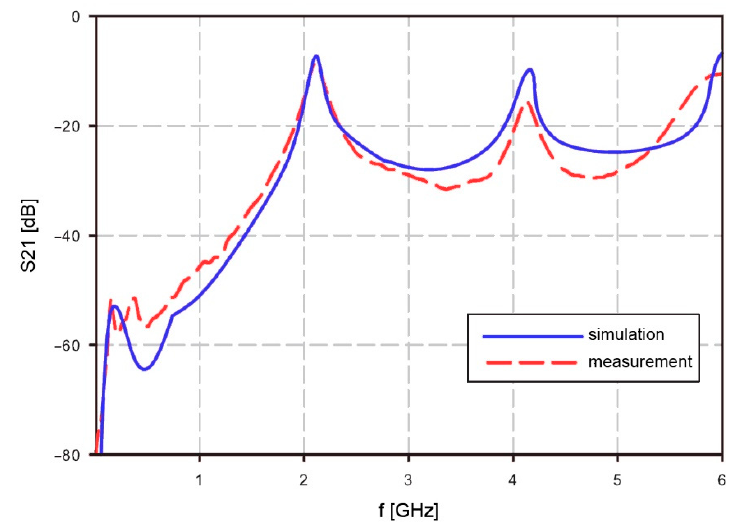
Figure 3. Calculated and measured S21 for resonator between 2 MHz and 6 GHz.